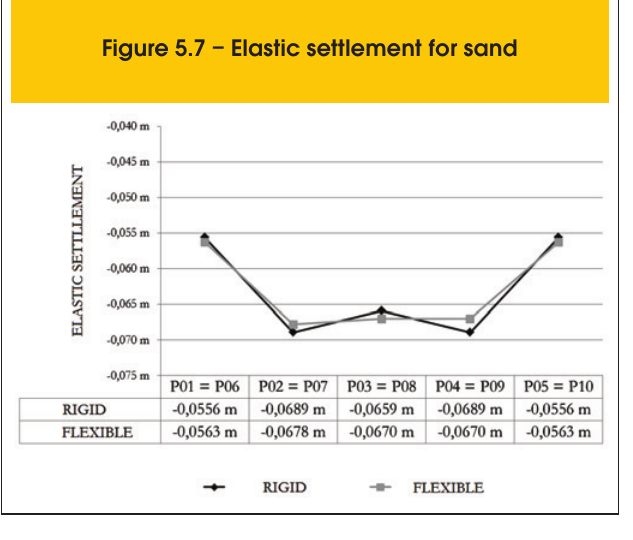
Figure 5.9 – Elastic settlement for sandy and clay soil